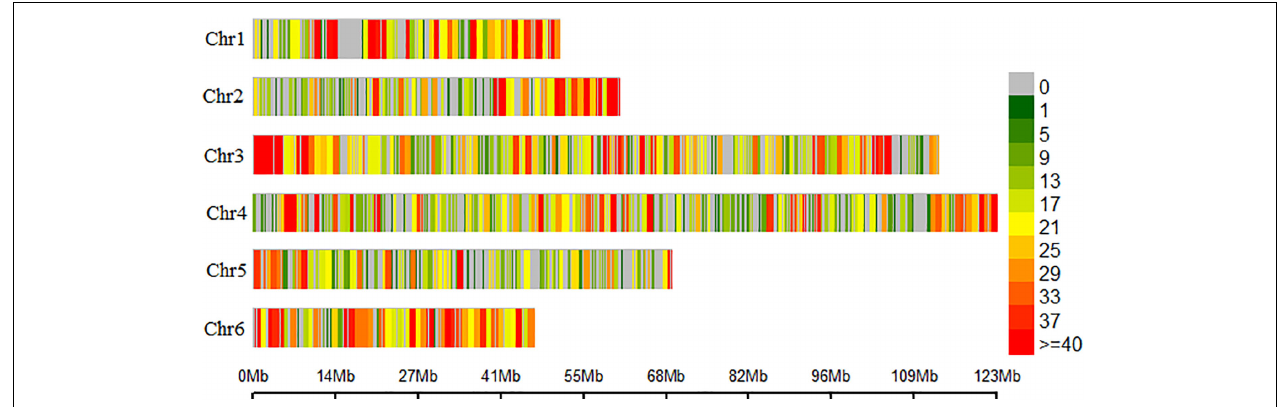
FIGURE 2 | Distribution of the single nucleotide polymorphism (SNP) marker on the six chromosomes of spinach. Spinach chromosomes are on the vertical axis. Chromosome length in Mb is on the horizontal axis, and the color represents the number of SNPs per window, SNP density.